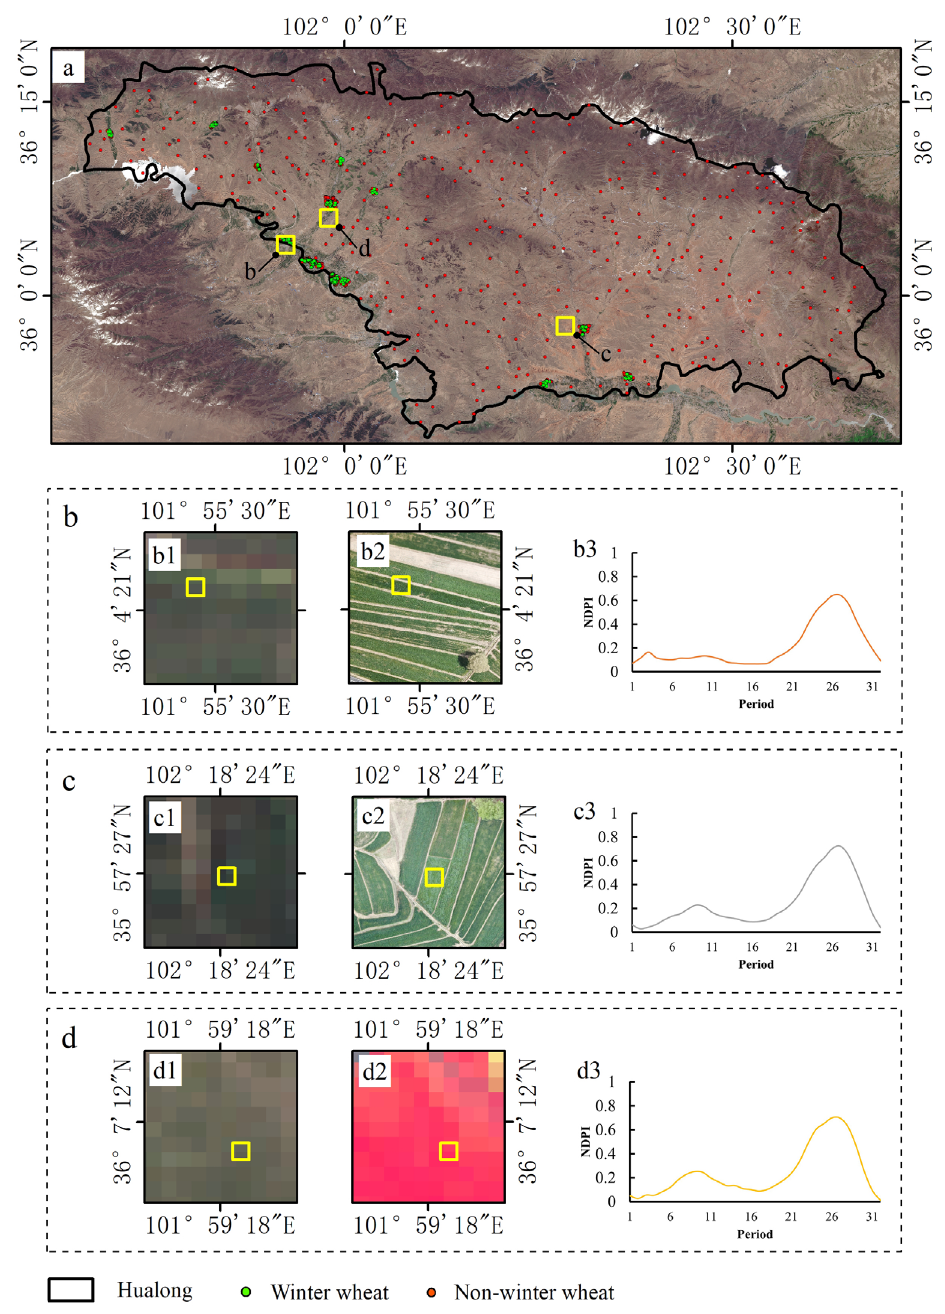
Figure 5. Sample selection. ( a ) Location of three samples in the study area; ( b1 , c1 , d1 ) Remote-sensing image of Sentinel 2A/B; ( b2 , c2 ) Quadrat image; ( d2 ) NDVI (normalized difference vegetation index) combination image; ( b3 , c3 , d3 ) Sample points corresponding to NDPI curves.